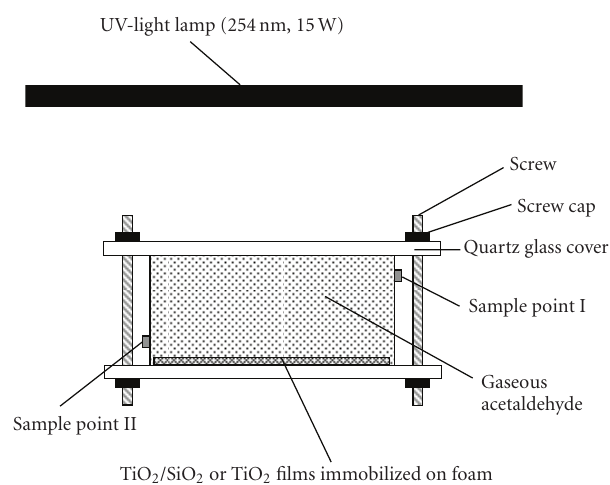
Figure 1: Schematic diagram of photoreactor for acetaldehyde pho- tocatalytic